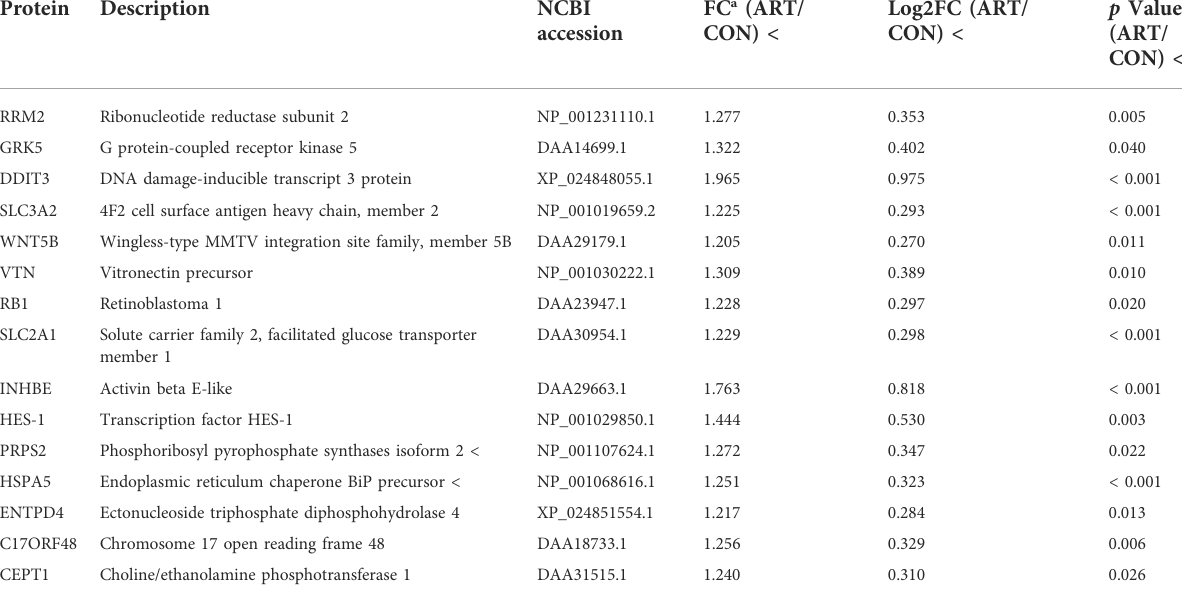
TABLE 2 Selected signi fi cantly upregulated proteins in the artemisinin (ART) group compared with the control (CON) group. Protein